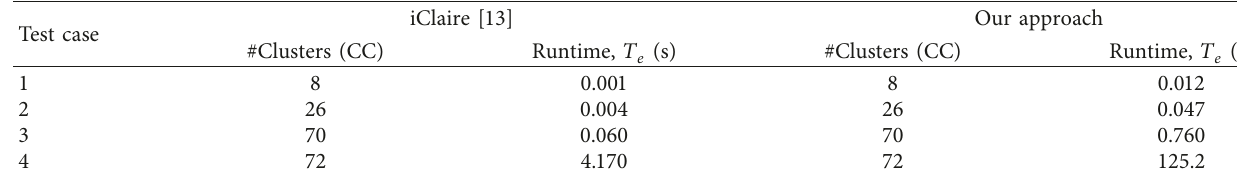
Table 3: Exact pattern matching (default constraint).